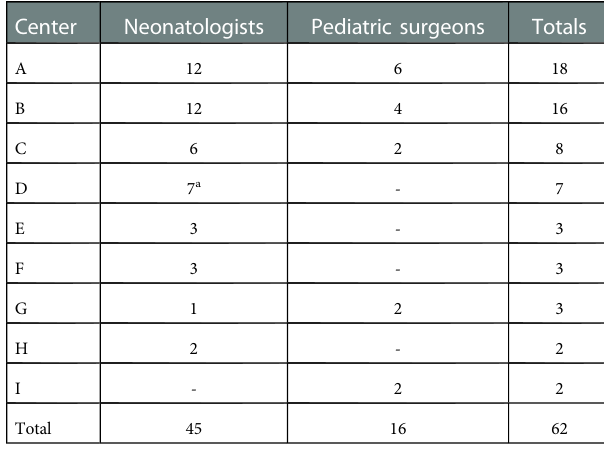
Table 3 depicts choices and regression analysis outcomes of neonatologists and pediatric surgeons. Overall, pediatric surgeons were somewhat more inclined to advice surgery when compared to